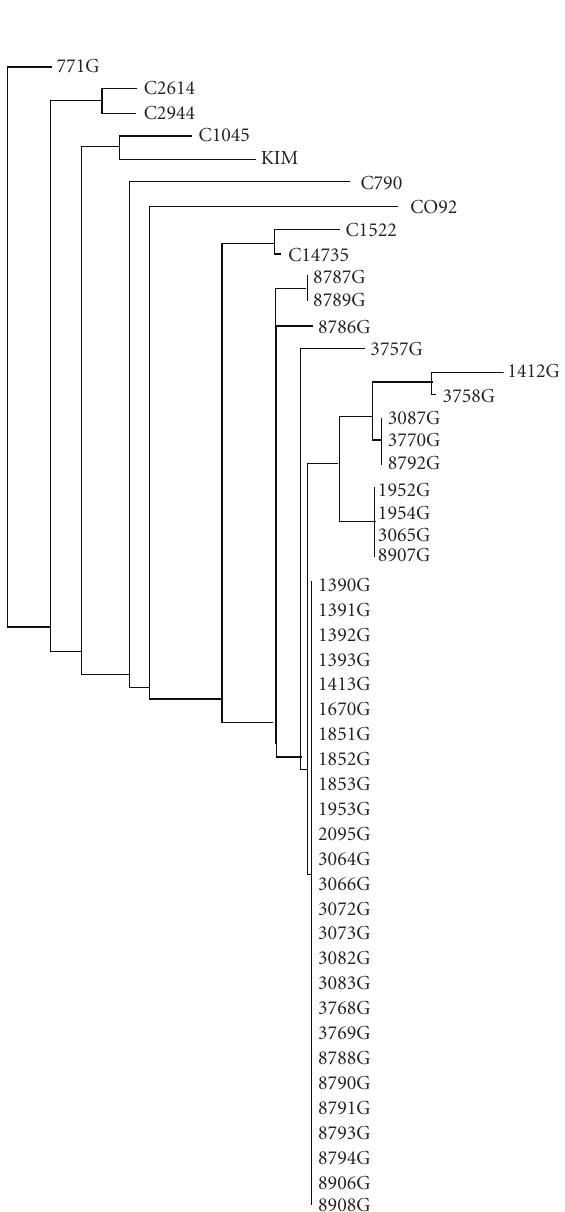
Figure 1: Neighbor-joining tree generated from MLVA data based on 7